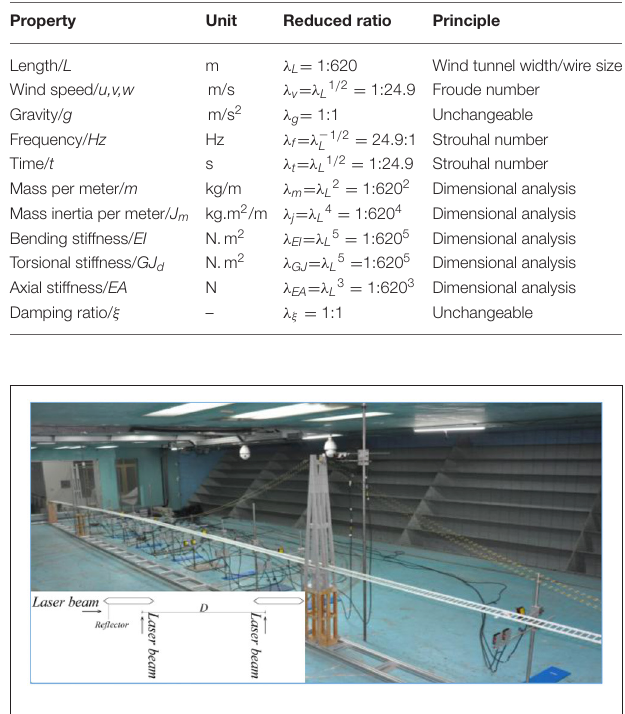
FIGURE 5 | Overview of the full bridge